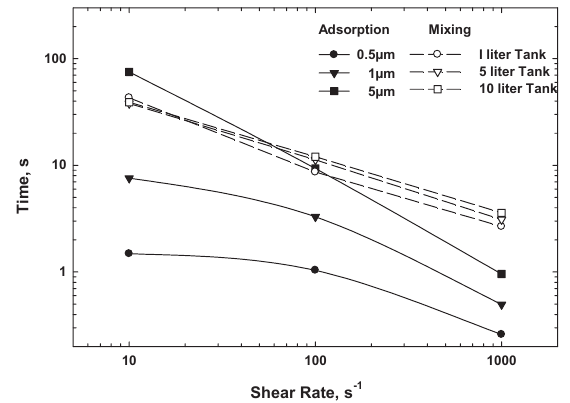
Fig. 5 Calculated adsorption and mixing times for sus- pensions at 1% solids by volume flocculated with a 10 million molecular weight